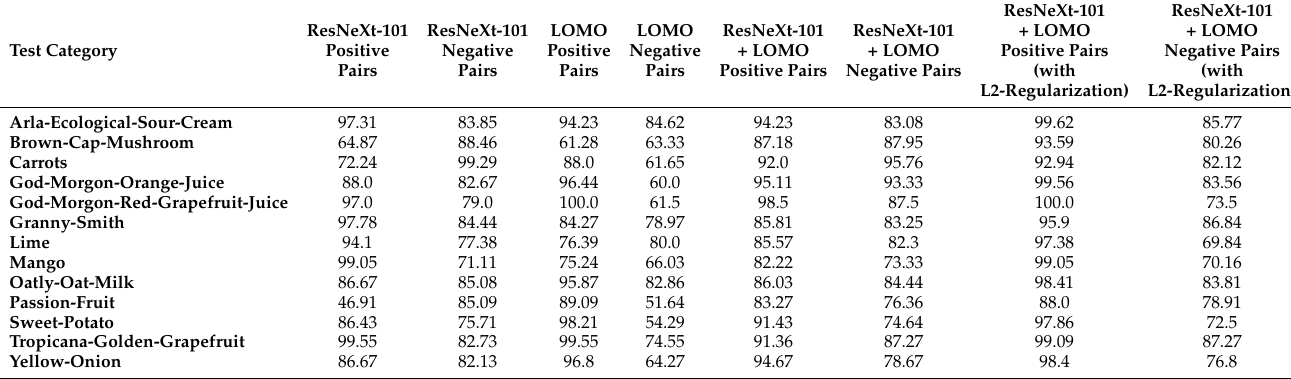
Table 5. Success rate by category of the proposed Siamese networks